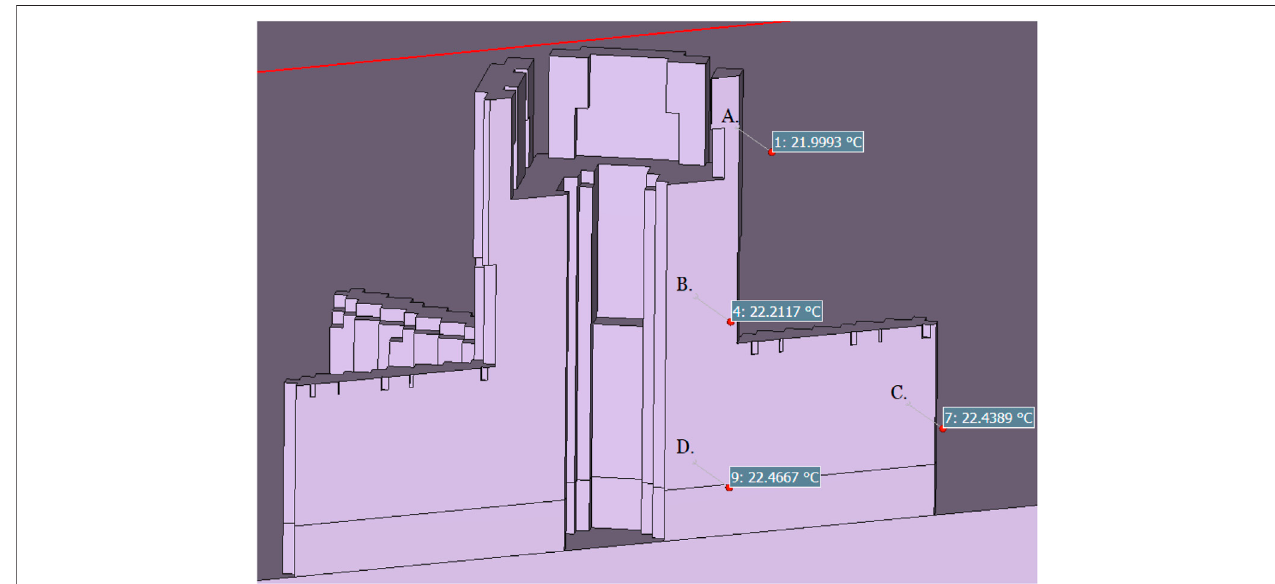
FIGURE 2 | Measuring points for temperature evolution in the